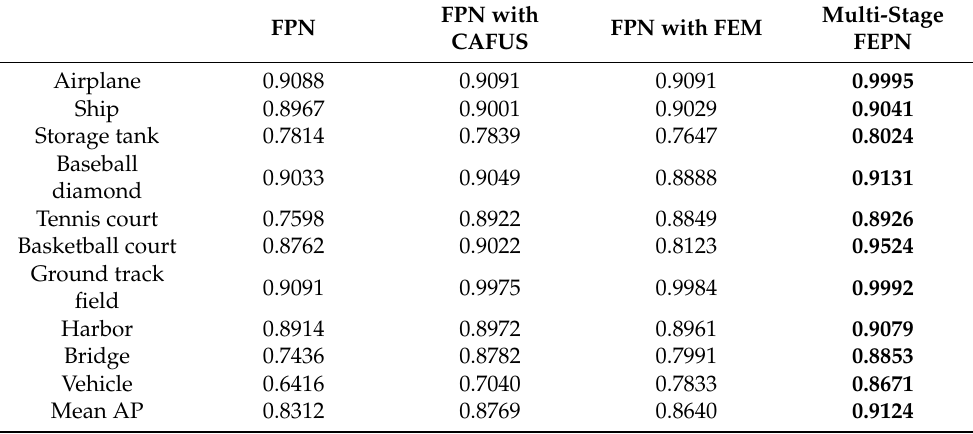
Table 2. The APs for each category of different methods and mAP in the ablation